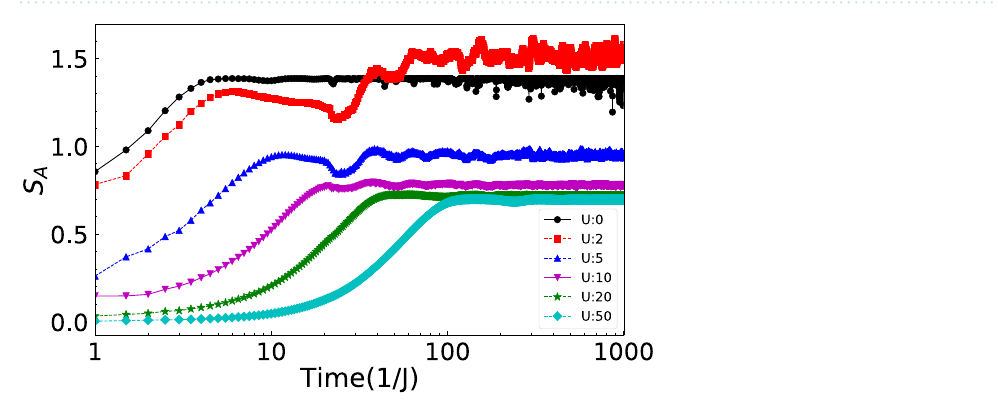
Figure 4. Shows the time evolution of S A ( t ) for U = 0, 2, 5, 10, 20, 50